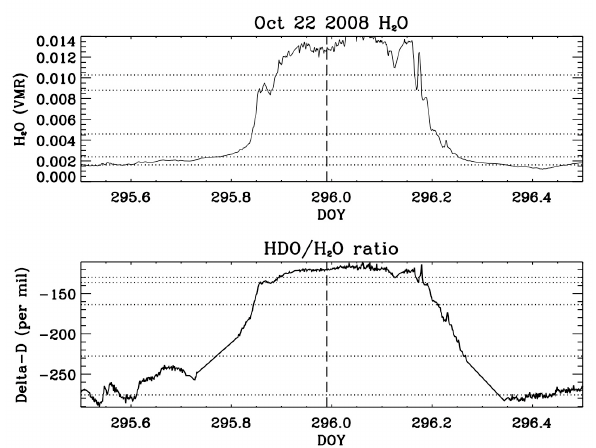
Fig. A4. Solid lines are the averaged values of the Picarro and LGR Figure A4. Solid lines are the averaged values of the Picarro and LGR in situ in situ measurements for H 2 O (top) and δ -D (bottom). The horizon- measurements for H 2 O (top) and δ -D (bottom). The horizontal dashed lines indicate the tal dashed lines indicate the water and δ -D values used to construct water and δ -D values used to construct the true HDO/ H O profile. The vertical dashed the true HDO/H 2 O profile. The vertical dashed line corresponds to 2 line corresponds to the time of the TES overpass. Fig. A6. Aqua MODIS image of the Hawaii islands for 5 November Figure A6. Aqua MODIS image of the Hawaii islands for Nov 05 2008 ~0 UTC. The big the time of the TES overpass. island is just south of 20 N. The blue cross marks the approximate location of the 2008 ∼ 00:00UTC. The big island is just south of 20 ◦ N. The blue observatory. cross marks the approximate location of the